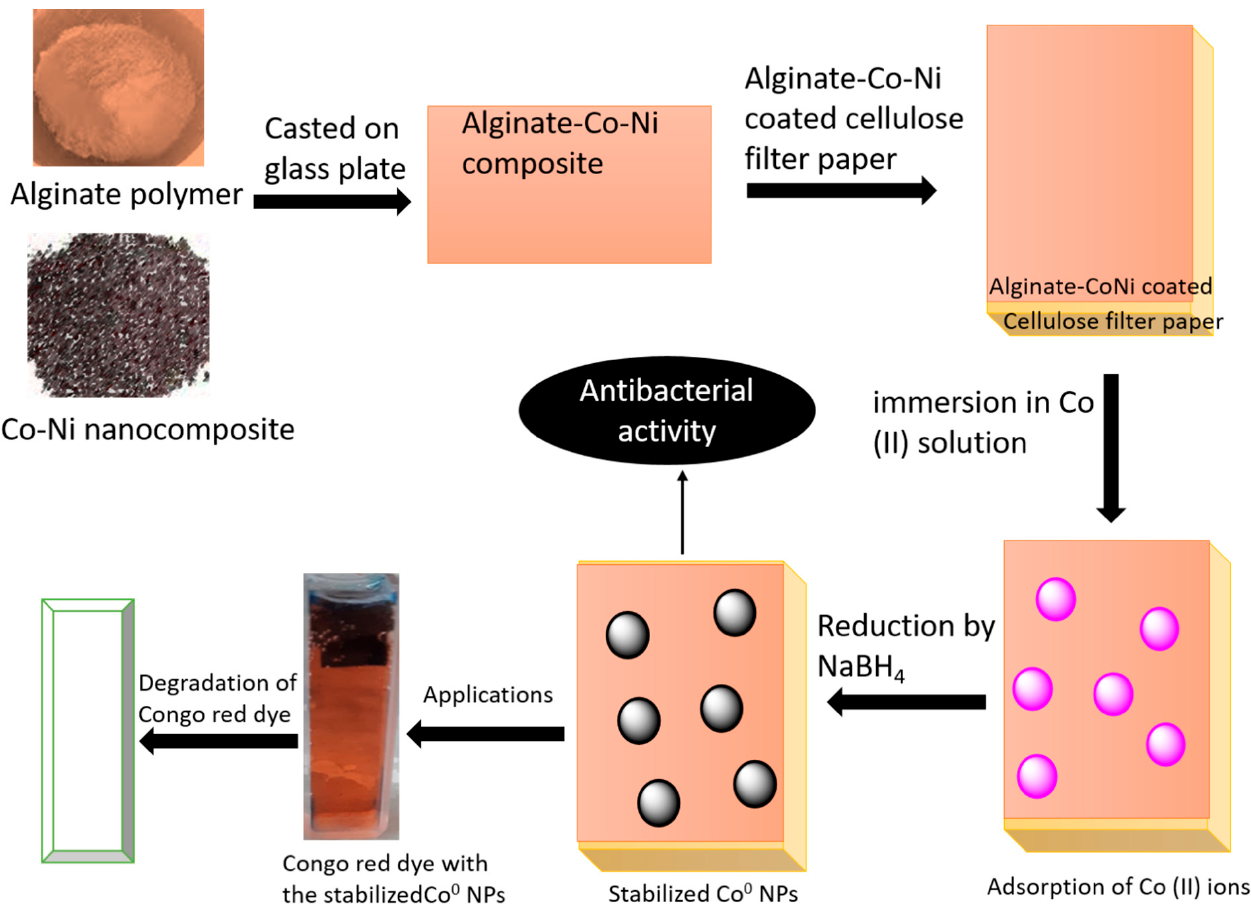
Scheme 1. Pictorial representation of the preparation of Alg-CoNi/FP@Co NPs and their applications against bacterial inhibition and degradation of dyes.